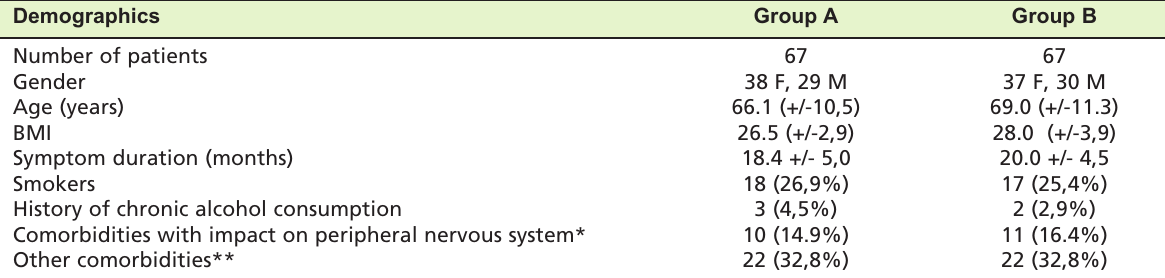
Clinical and demographic features Table II: